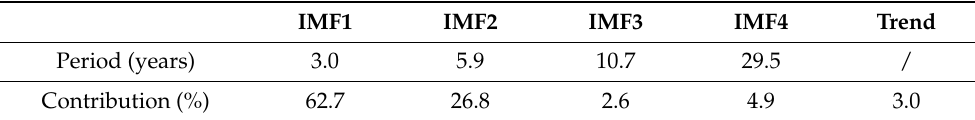
Table 2. Contribution and period of precipitation components after